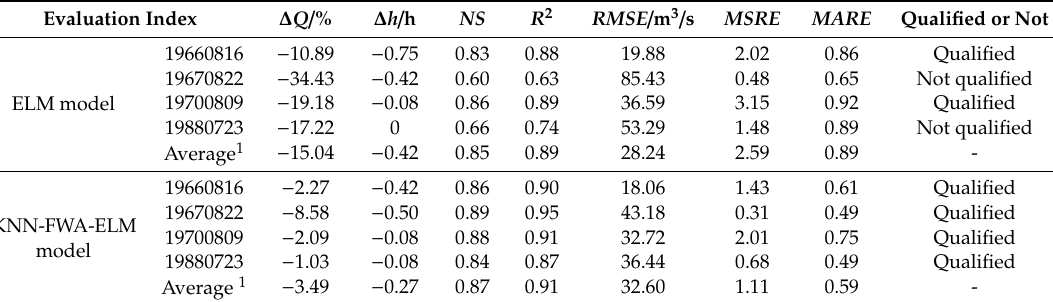
Table 7. Comparison of great flood simulation